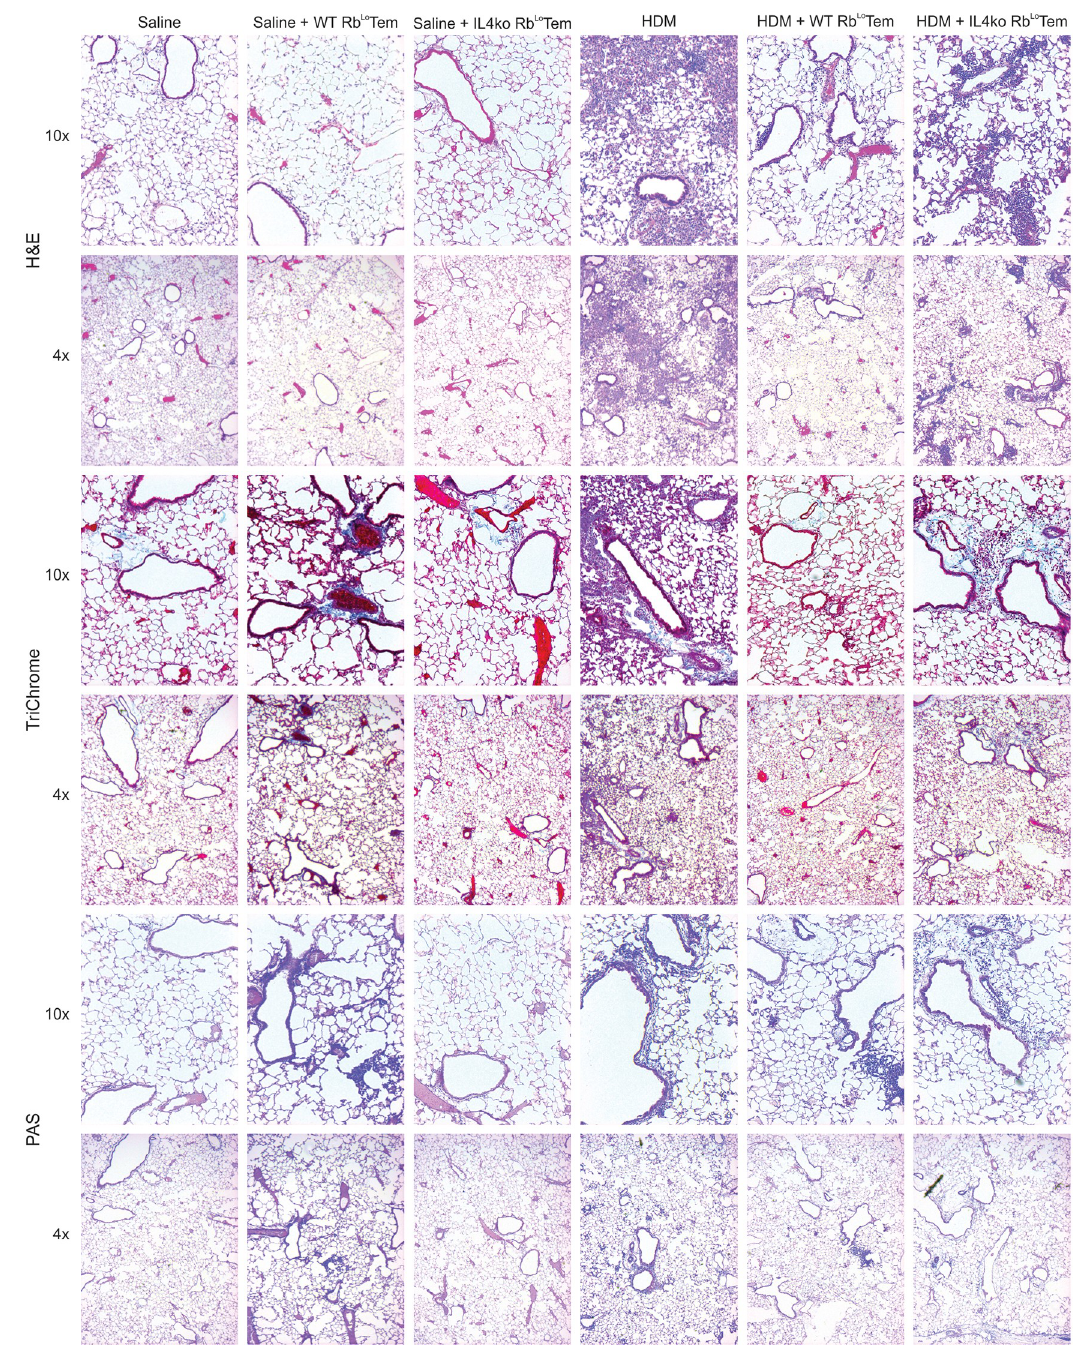
Fig 7. Lung inflammation, remodeling and mucus production is reversed by Rb Lo Tem cells in an IL-4-dependent fashion. Representative lung sections from n = 6 mice at 4x and 10x magnification from the mice described in Fig 6 were stained with H&E (top), TriChrome (middle) and PAS (bottom) to assess cellular infiltration, tissue remodeling/collagen deposition and mucus production respectively in HDM-challenged mice receiving 60,000 activated WT or IL-4ko Rb Lo Tem cells.